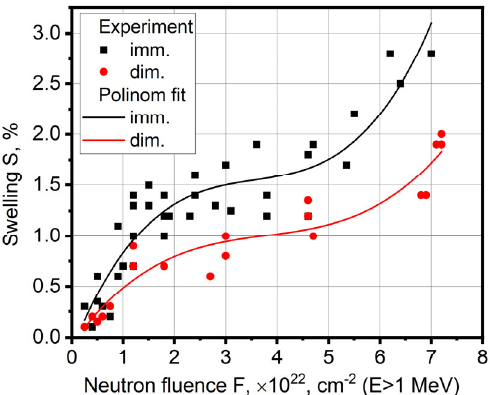
Figure 3. Dependence of swelling S of titanium beryllide Be ‐ 7Ti on irradiation temperature, reactor HFR, F = (0.73–1.82) ∙ 10 22 cm − 2 (E > 1 MeV) (dim.—dimension, imm.—immersion, pyc.—pycnometry, H ‐ 1—HIDOBE ‐ 01, H ‐ 2—HIDOBE ‐ 02).